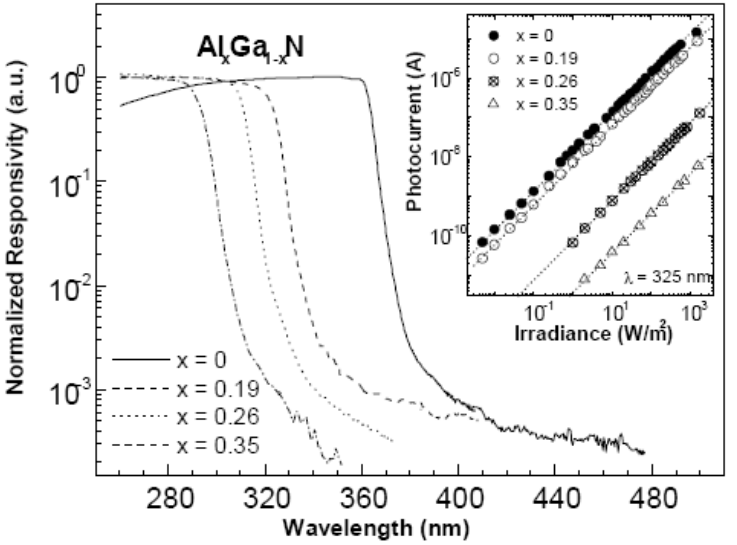
Figure 3. Spectral response of AlGaN-based Schottky barrier photodiodes for different Al mole fraction. (Reprinted from Reference